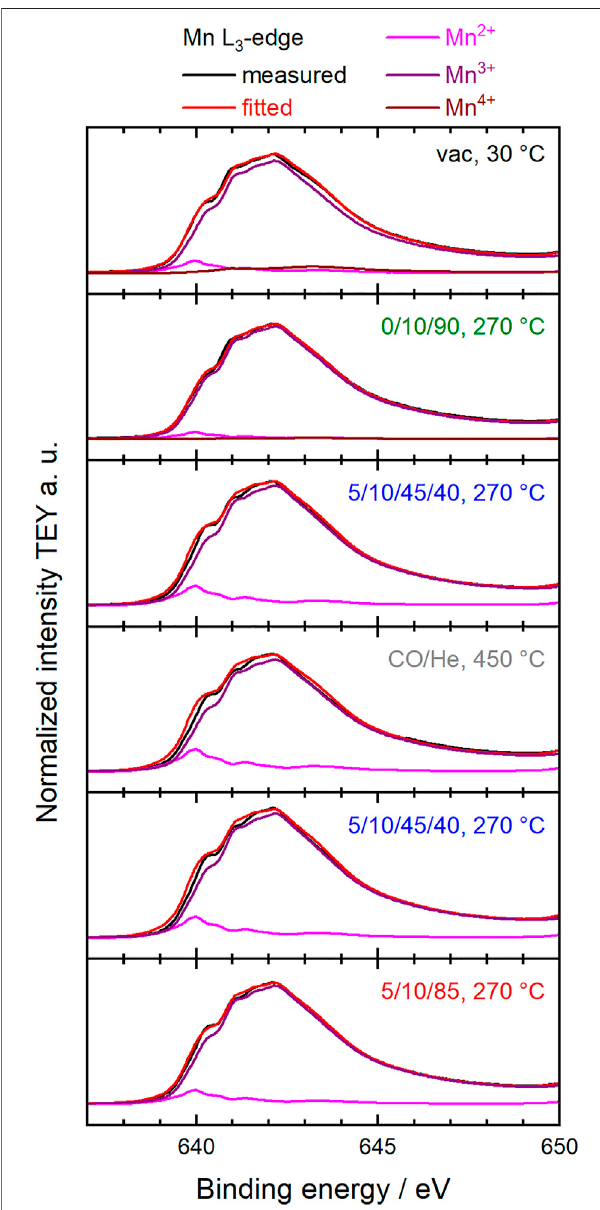
FIGURE 3 | Measured and normalized TEY Mn L 3 -edges (black) and corresponding fi tted spectra (red) using a linear combination of reference spectraofMn 2+ (pink),Mn 3+ (purple)andMn 4+ (brown)(Kochetal.,2020).The conditions during the measurements at the synchrotron facility are indicated in each diagram in terms of temperature and feed compositions C 3 H 8 /O 2 /He or C 3 H 8 /O 2 /He/H 2 O.